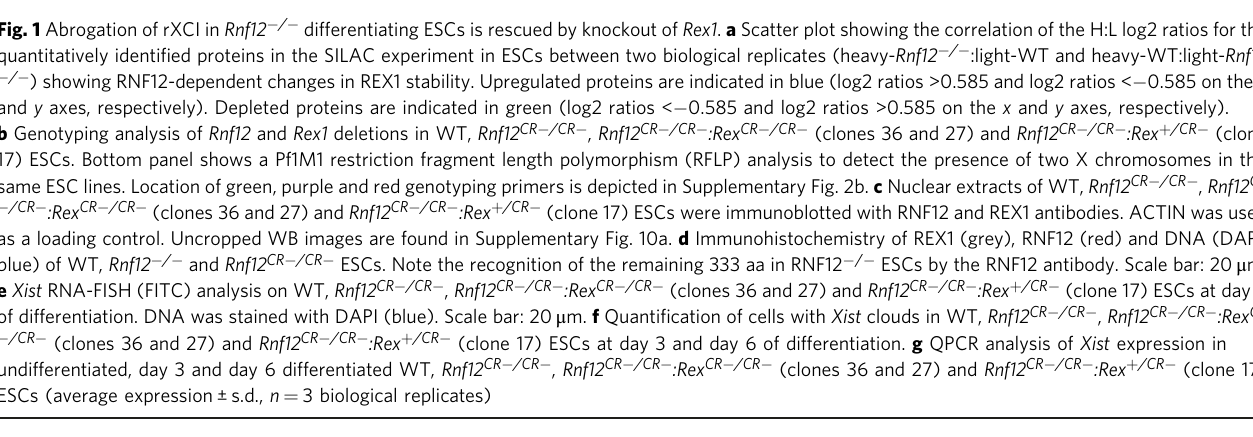
(Supplementary Fig. 7a, b). Allele-speci fi c expression analysis in Rex1 − / − and WT E11.5 female embryos of X-linked genes Xist , G6pdx and Mecp2 indicated normal iXCI and rXCI, with preferential inactivation of the paternally inherited X (cas) in the VYSE of F1 129:cas embryos, and rXCI in embryonic tissues (Fig. 3e, f; Supplementary Fig. 7c). rXCI is skewed in 129:cas